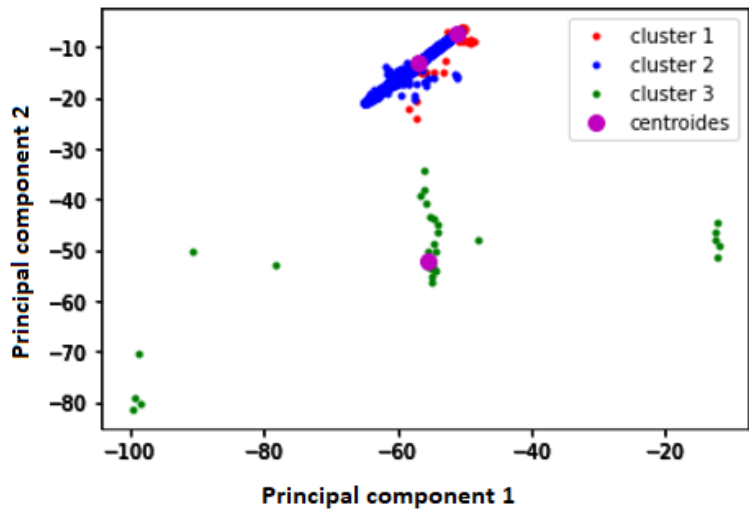
Figure 4. ANN convergence trained with real data.